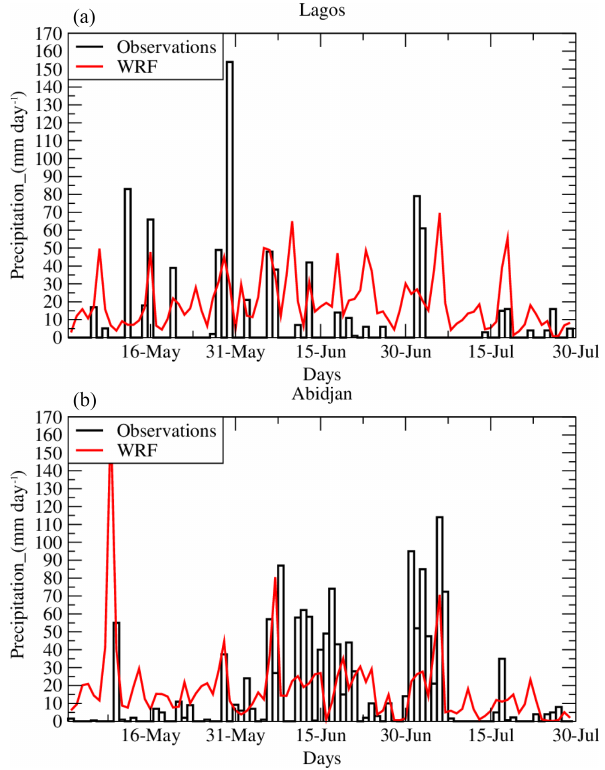
Figure C2. Time series of 24h accumulated precipitation from the BADC stations and the corresponding model cell: Lagos (a) and Abidjan (b) .